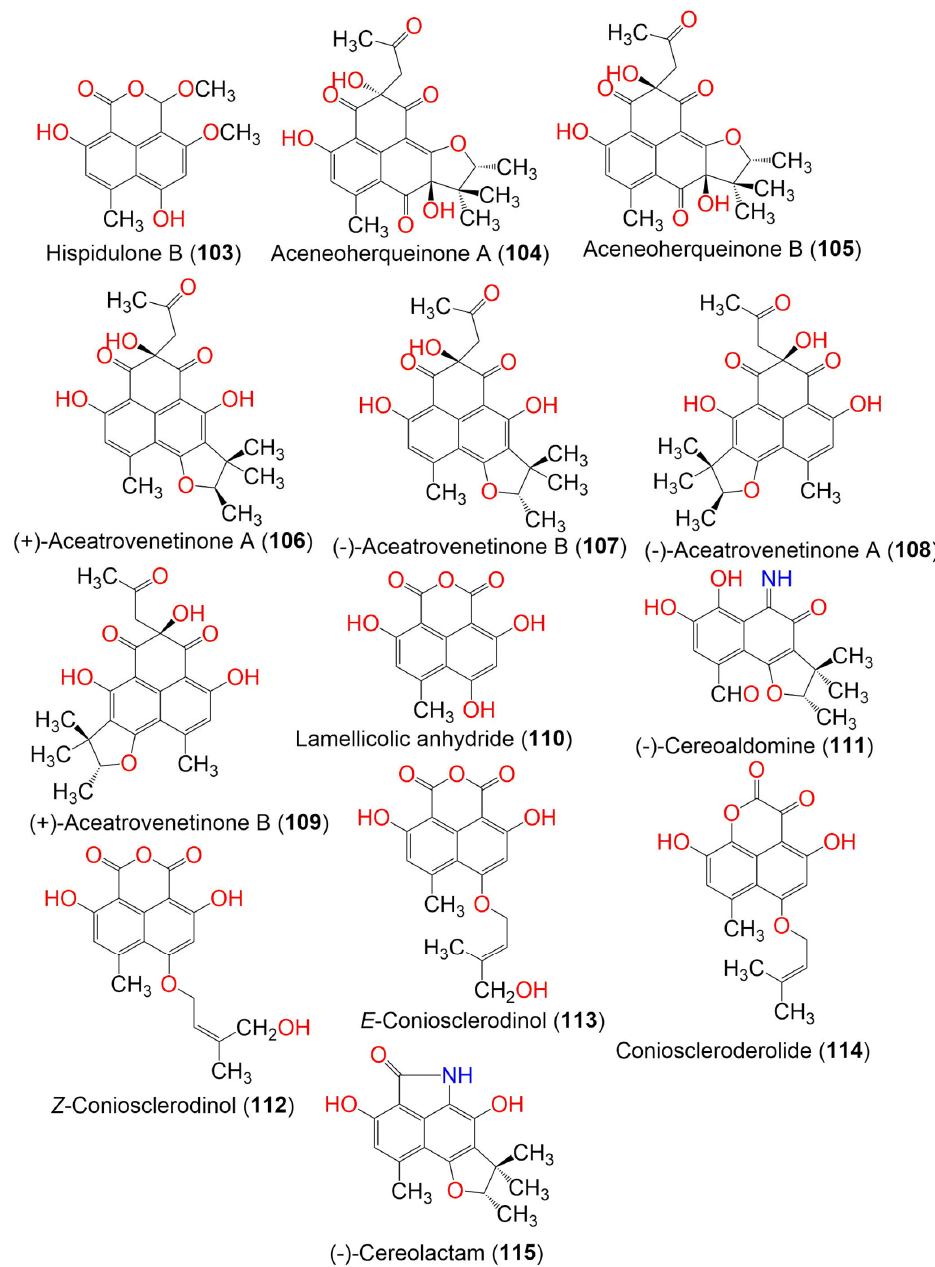
Figure 11. The structures of compounds 103 – 115 .